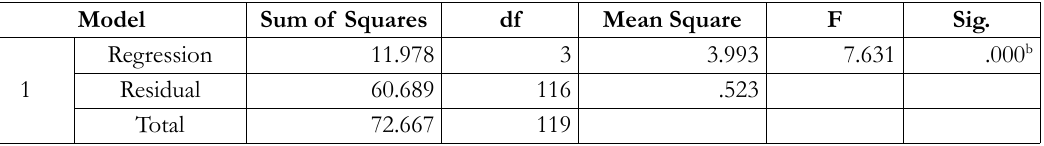
Table 3. Αnova Αnalysis